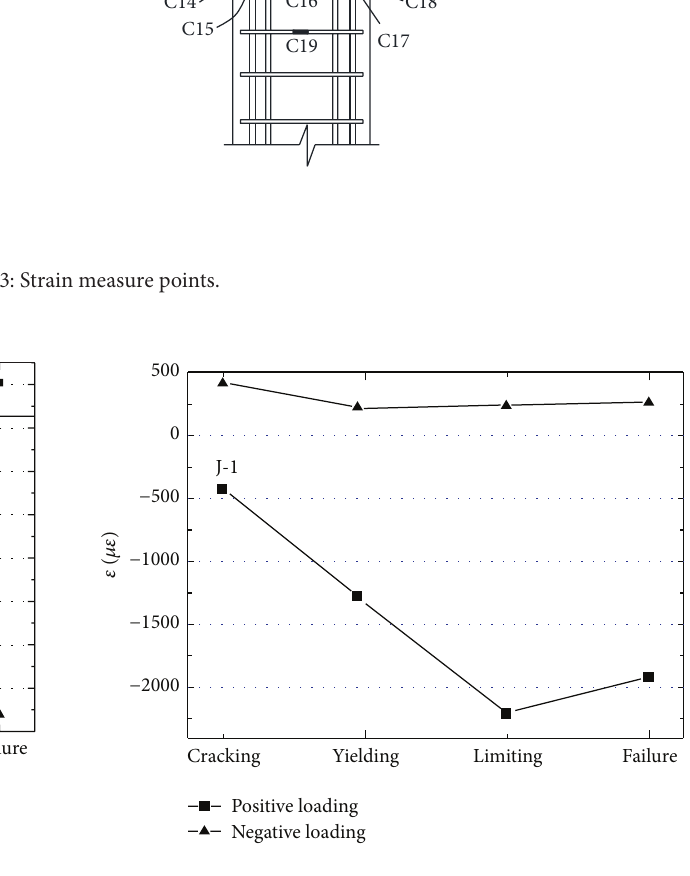
Figure 15: Strain of column steel